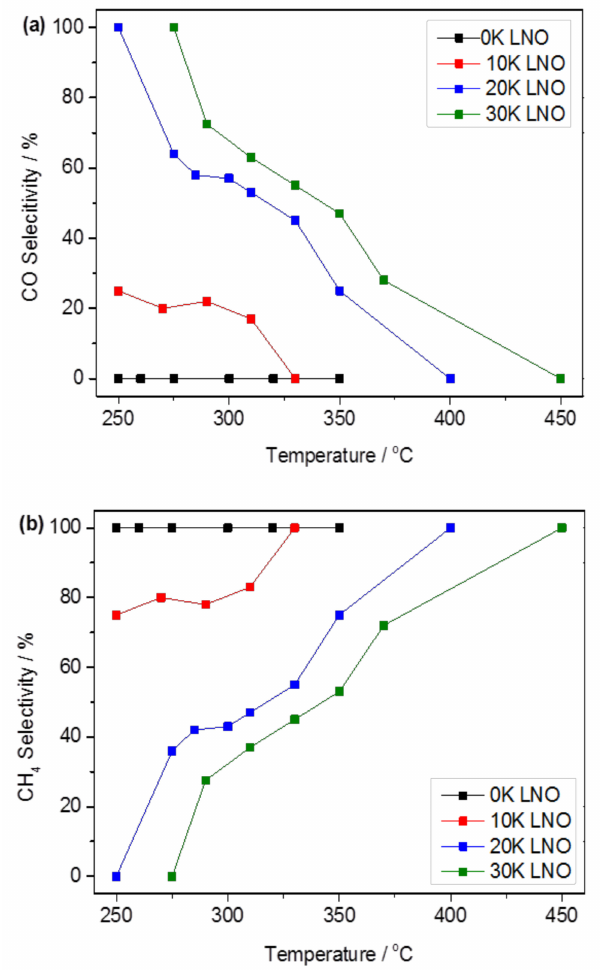
Figure 6. ( a ) Reaction selectivity towards the rWGS reaction and ( b ) reaction selectivity towards Sabatier methanation for all samples for 0–100%